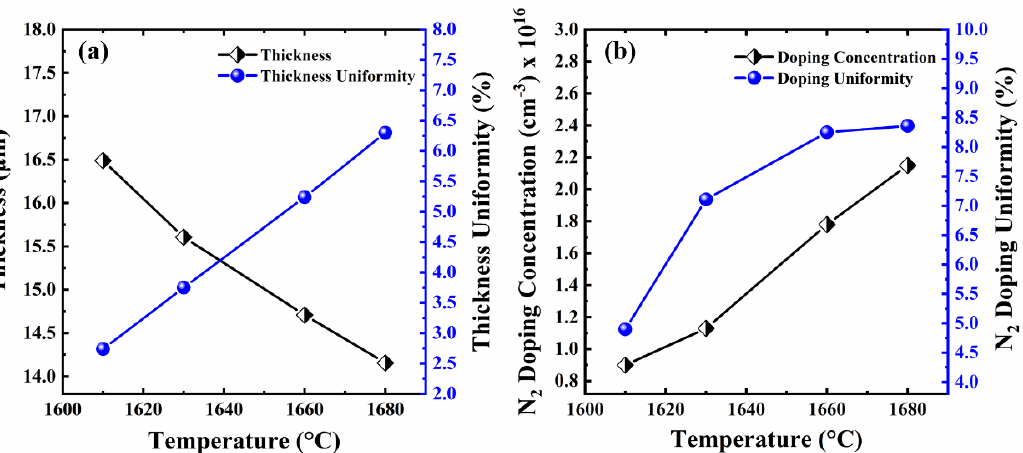
Figure 4. Thickness and doping concentration at various temperatures: ( a ) thickness and thickness uniformity, ( b ) N 2 doping concentration and doing